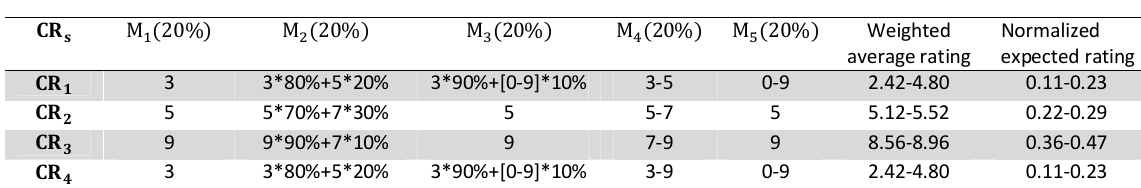
Expected rating for the relative importance of Rumlet criteria